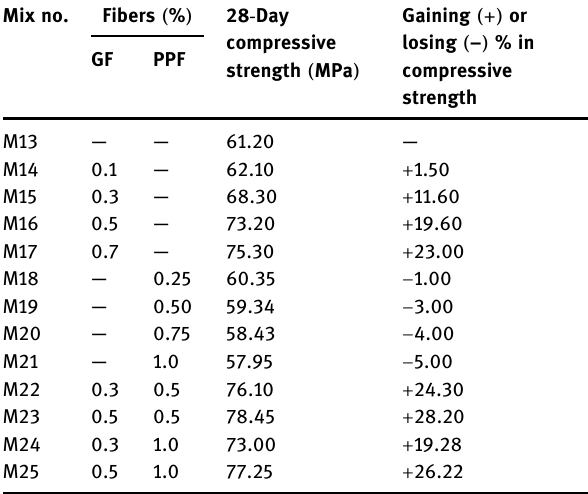
Table 12: Compressive strength test results of HSC mixes Mix no. Fibers ( %